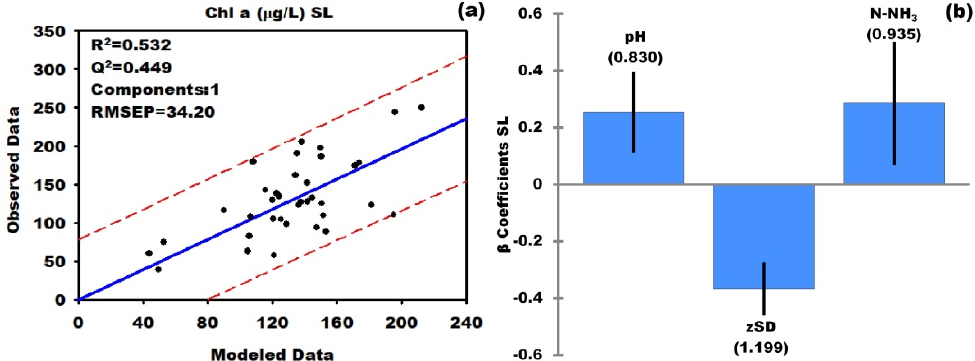
Figure 5. ( a ) SL Chl a modeled vs. observed data, regression line (solid line), 95% prediction confidence intervals (dashed lines), and model performance metrics; ( b ) SL β coefficients for retained variables (bars), confidence intervals (solid lines), and VIP in parentheses.